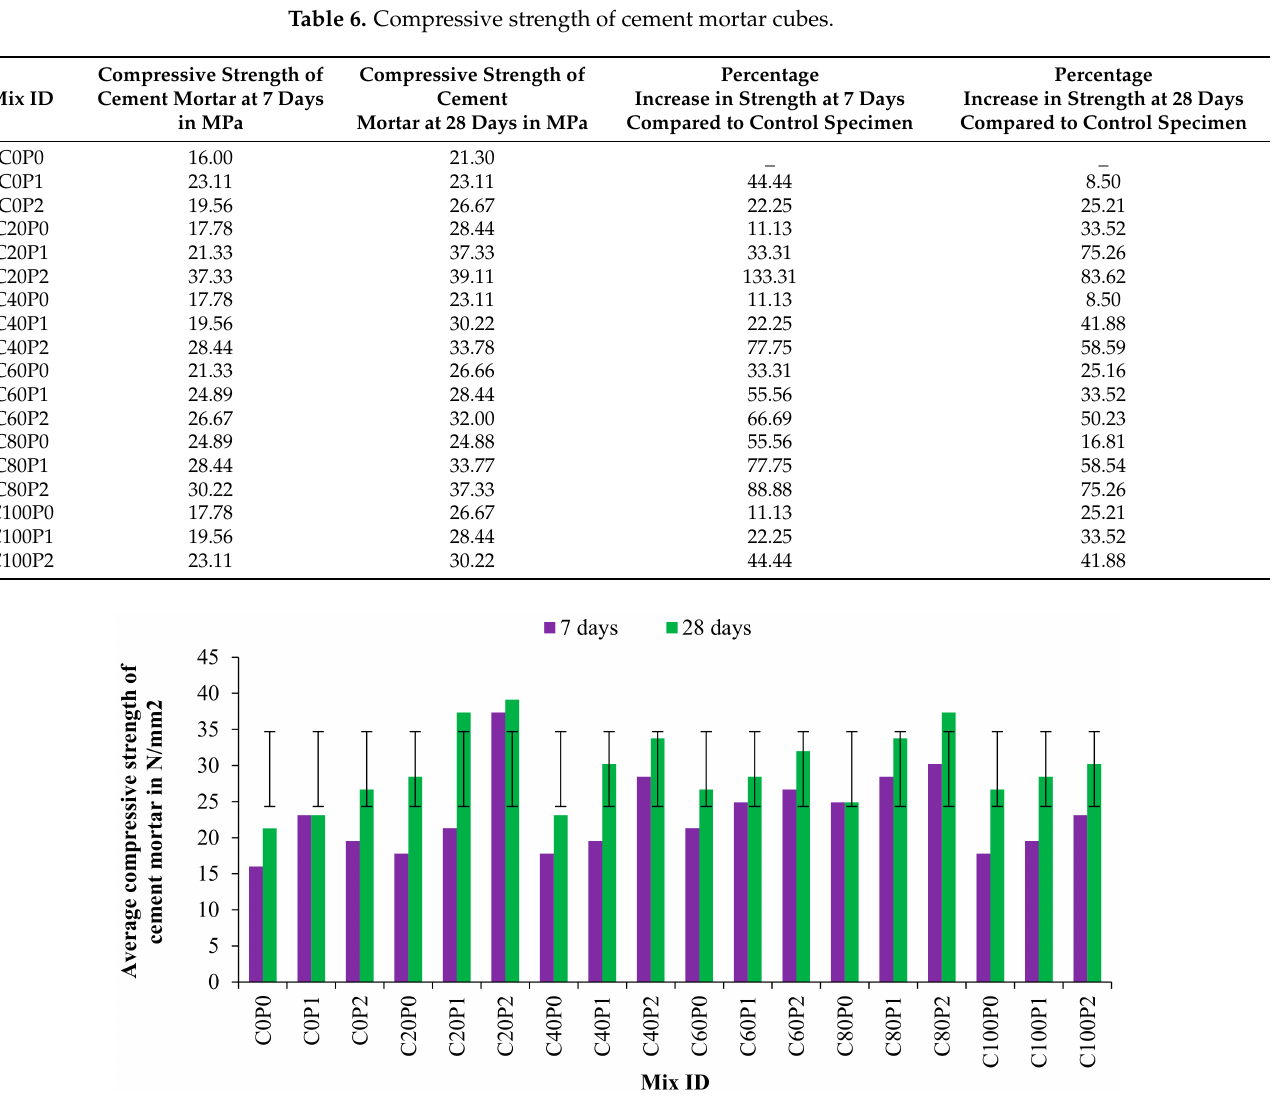
Figure 10. Compressive strength of cement mortar